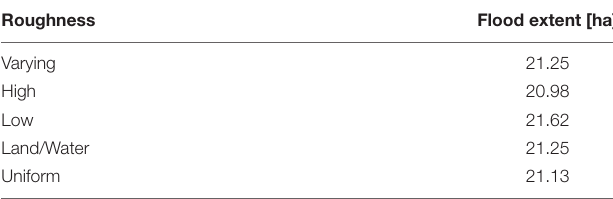
TABLE 4 | Flood extent in case of changes in roughness